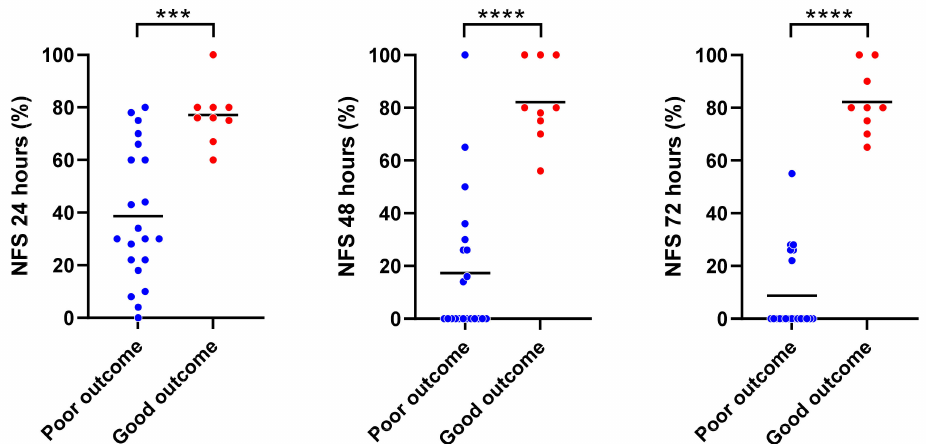
Figure 4. Daily neurological functional scores (NFS) in the good and poor outcome groups after the return of spontaneous circulation (ROSC). The good neurological outcome group exhibited markedly higher NFS at 24, 48, and 72 h post-ROSC. Lines indicate mean; *** p < 0.001, **** p <